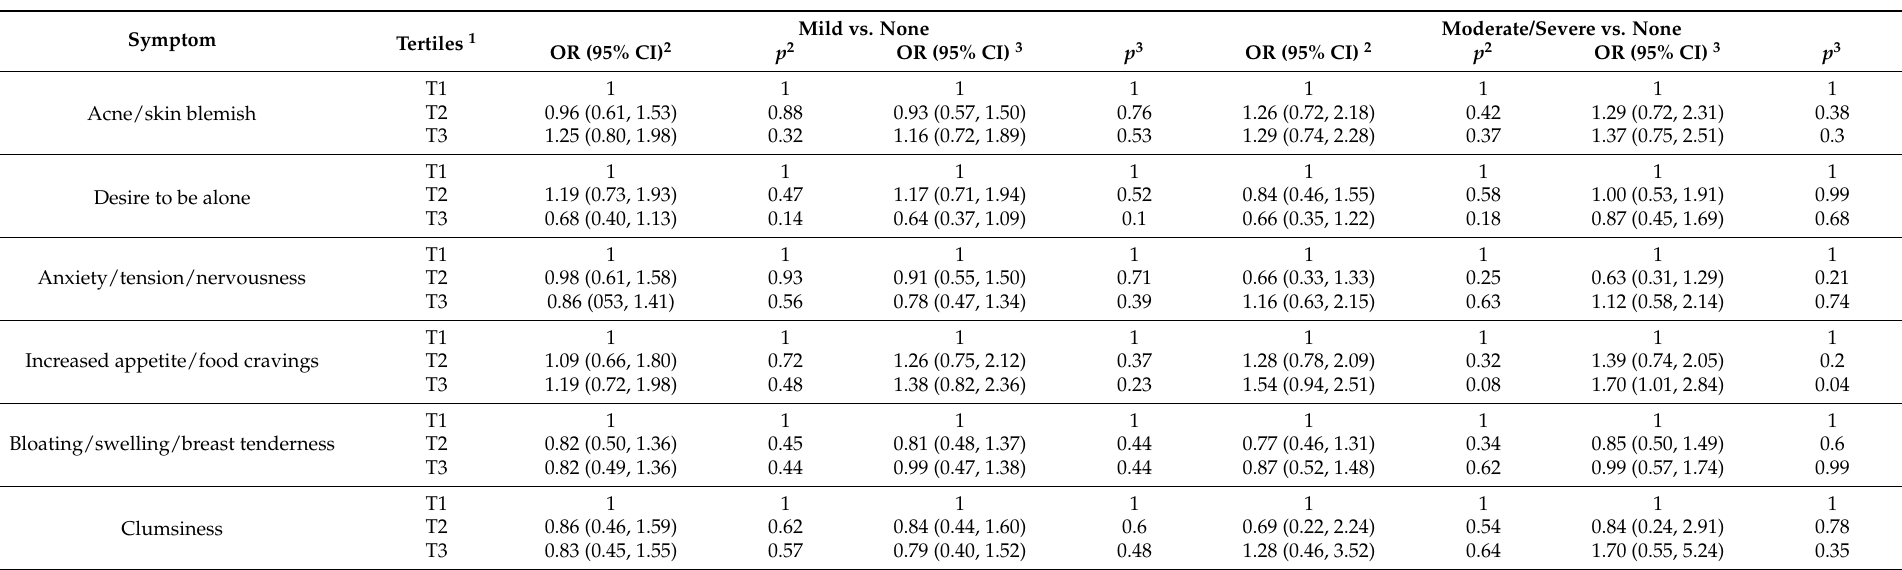
Table 3. Unadjusted and adjusted Odds Ratios and 95% CIs for the association between tertiles of plasma beta-carotene and premenstrual symptoms.